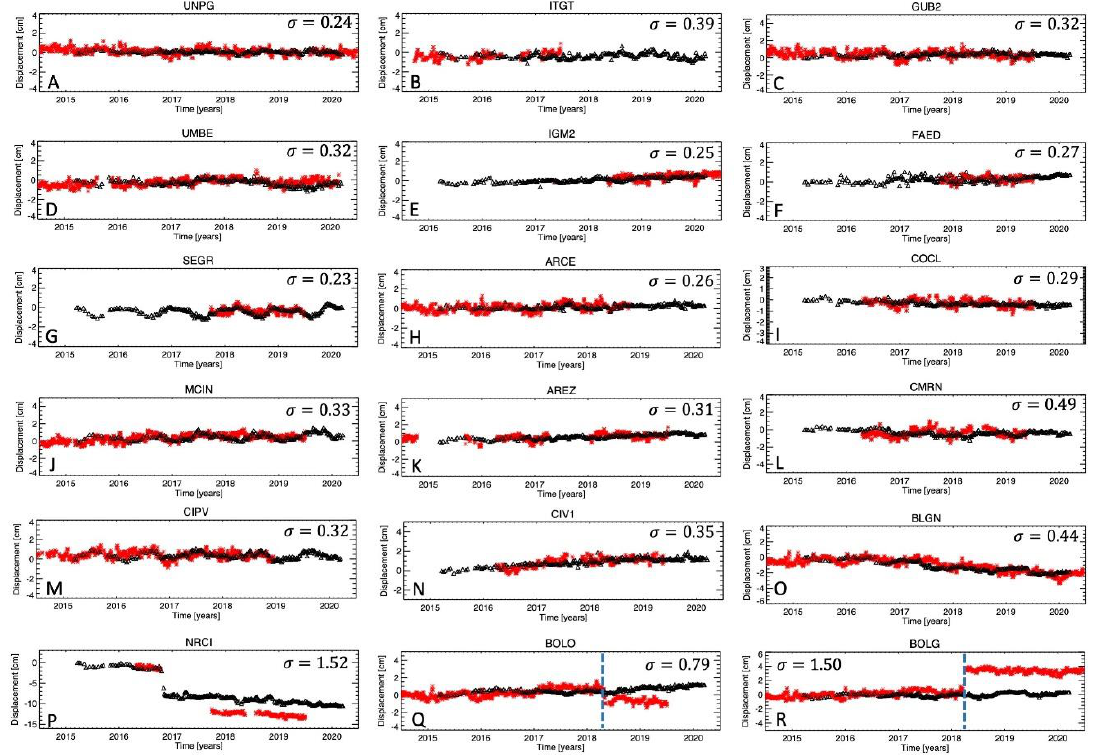
Figure 8. ( A–R ) Comparison between the P-SBAS (black triangles) and the LOS-projected GNSS (red stars) deformation time series relevant to the stations labelled in Figure 7 with capital letters from A to R. The standard deviation values (in cm) of the difference between the two time series are also reported.